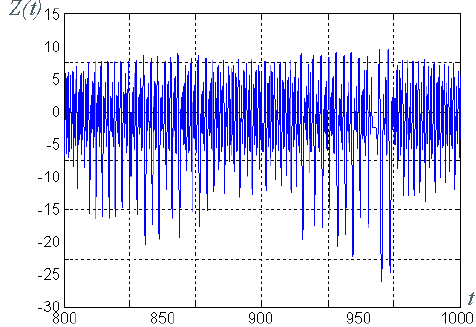
Figure 6. Encoded signal with rectangular pulses in the communication channel (state variable Z(t) ).